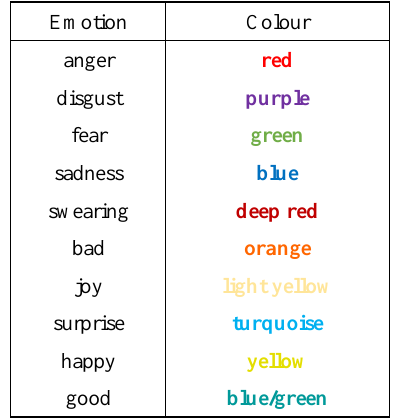
Table 5 . Chosen colours for each emotion. The extracted information (environmental terms, locations) connected with each of them inherits the emotion’s colours for visualization